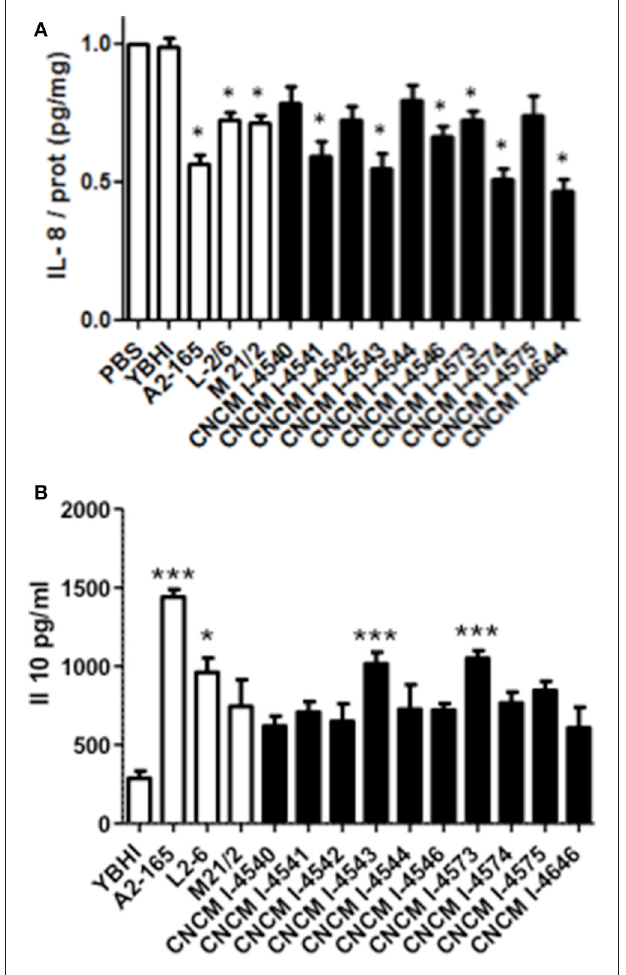
FIGURE 6 | Immuno-modulation capacities of F. prausnitzii strains in vitro. (A) IL-8 production in HT-29 TNF- α stimulated cells. Experiments have been done at least in triplicate. Results are expressed as IL-8/ protein (pg/mg) and have been normalized using as reference value the IL-8 produced after the co-incubation with PBS as a negative control. (B) IL-10 production in peripheral blood mononuclear cells. Experiments have been done at least in triplicate. Results are expressed as IL-10 concentration (pg/mL). Significant differences from the control (YBHI) was specified as: * p < 0.05 and *** p < 0.001.